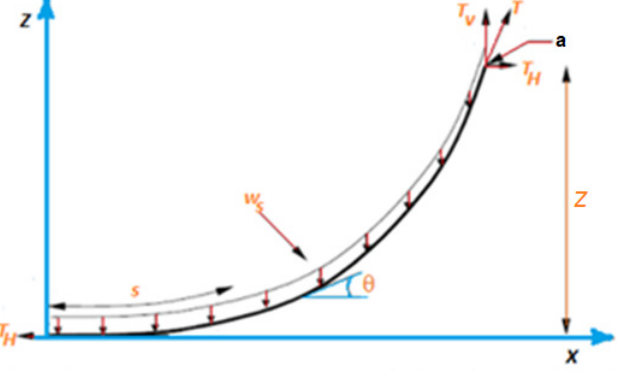
Figure 17. Forces on the catenary design of a mooring line.